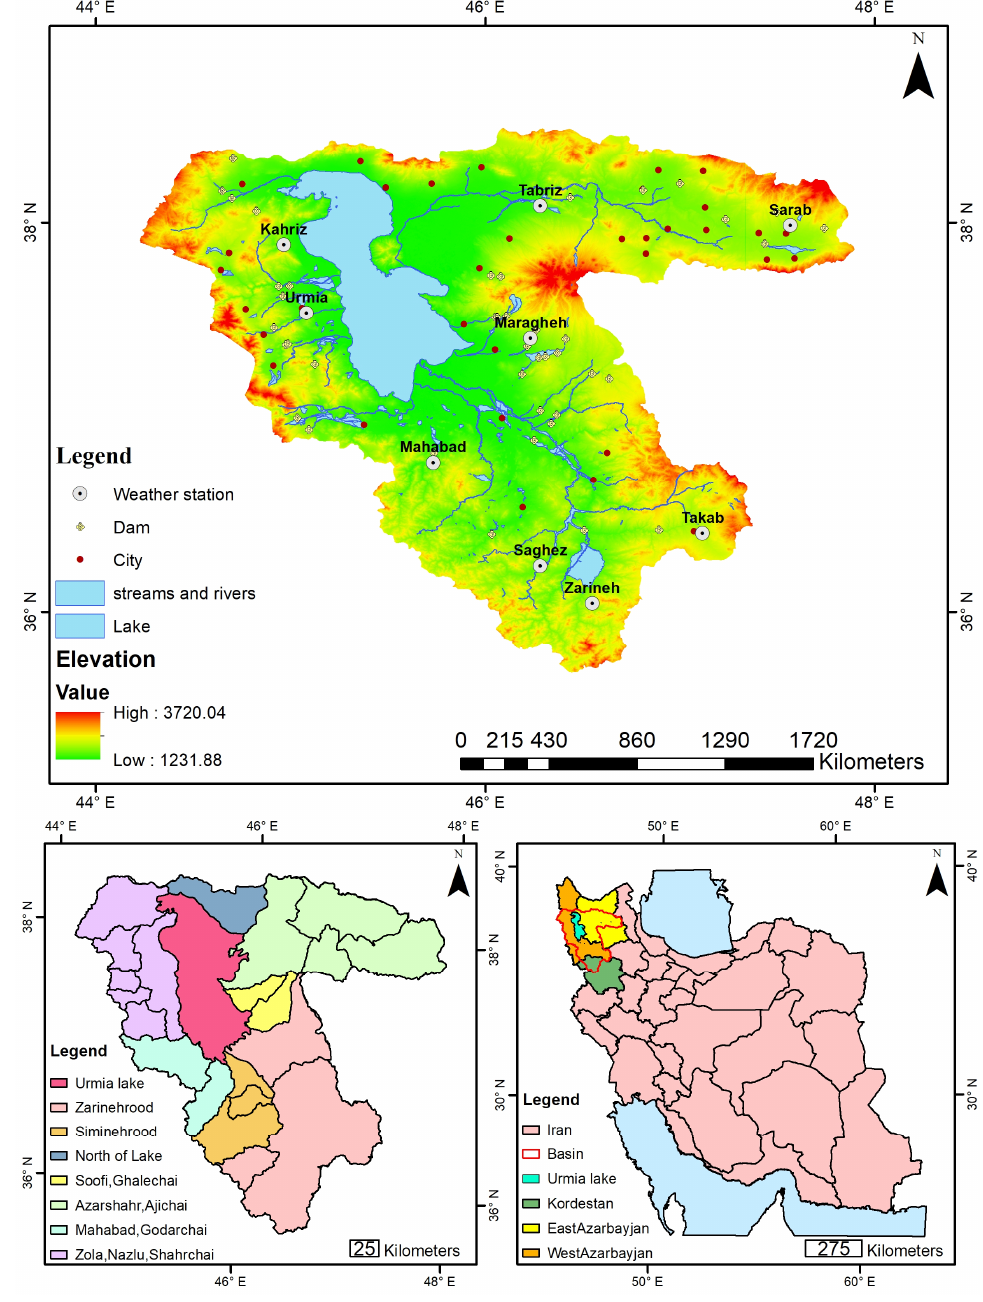
Figure 2. Geographical location of Lake Urmia.